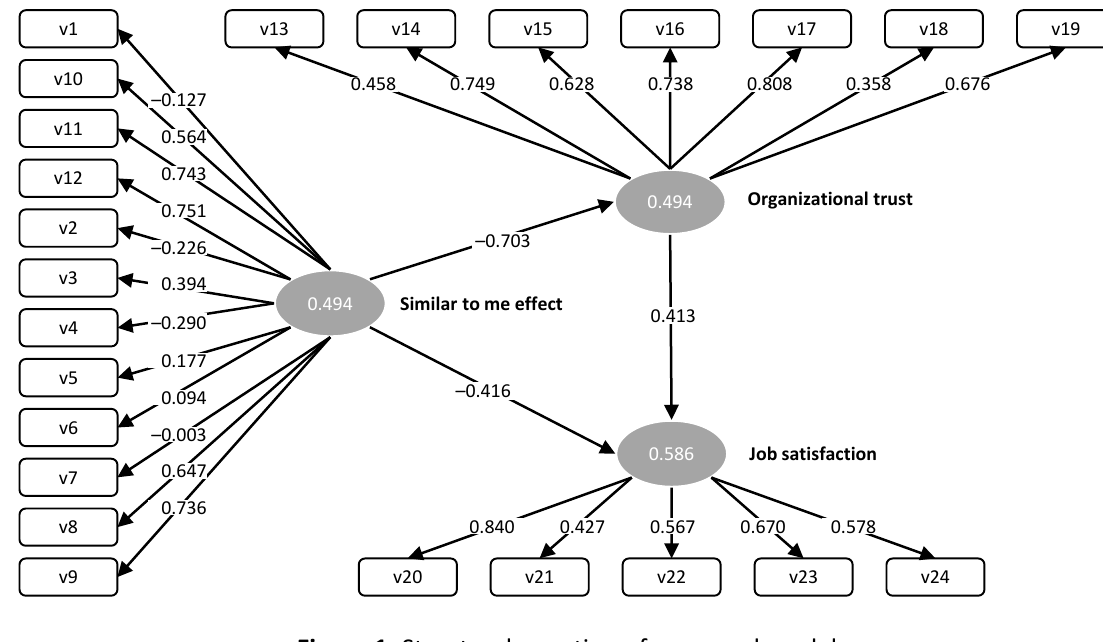
Figure 1. Structural equation of proposed